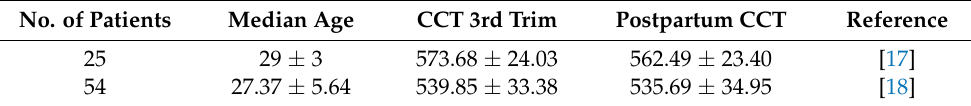
Table 2. Central corneal thickness values during the third trimester and postpartum.